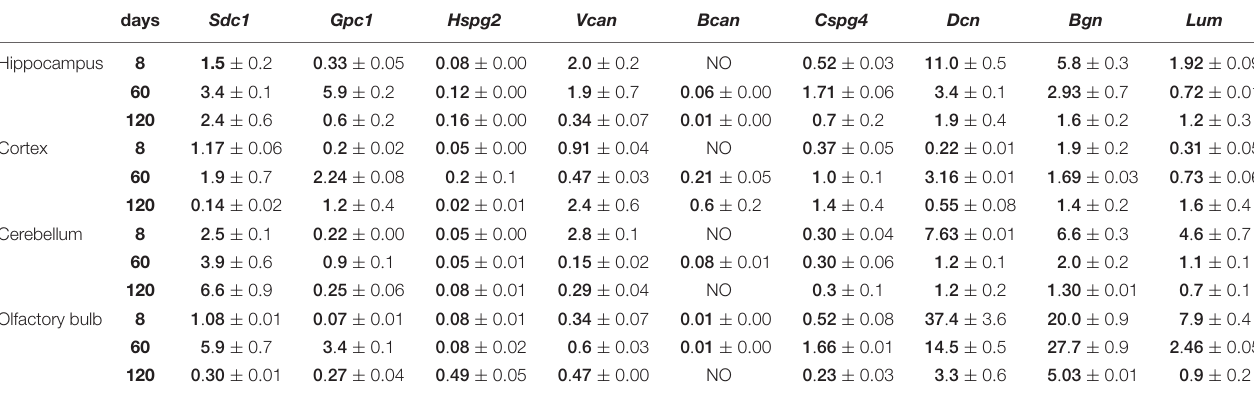
FIGURE 2 | Proteoglycans expression in different brain zones of 8, 60, and 120-day old Wistar rats. RT-PCR analysis, intensity of the amplified DNA fragments normalised to that of Gapdh from triplicate experiments, Student’s t -test (OriginPro 8.1). Stacked column compares the contribution of each value to a total across categories. TABLE 2 | Expression of proteoglycans in various Wistar rat brain zones at different